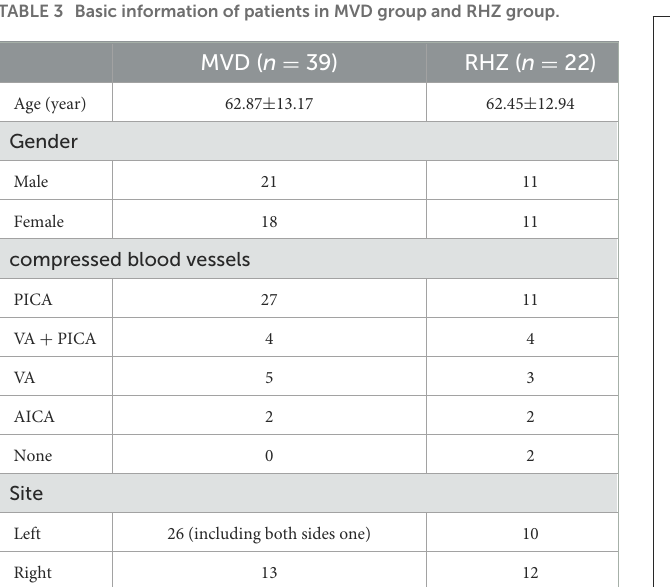
TABLE 3 Basic information of patients in MVD group and RHZ group.